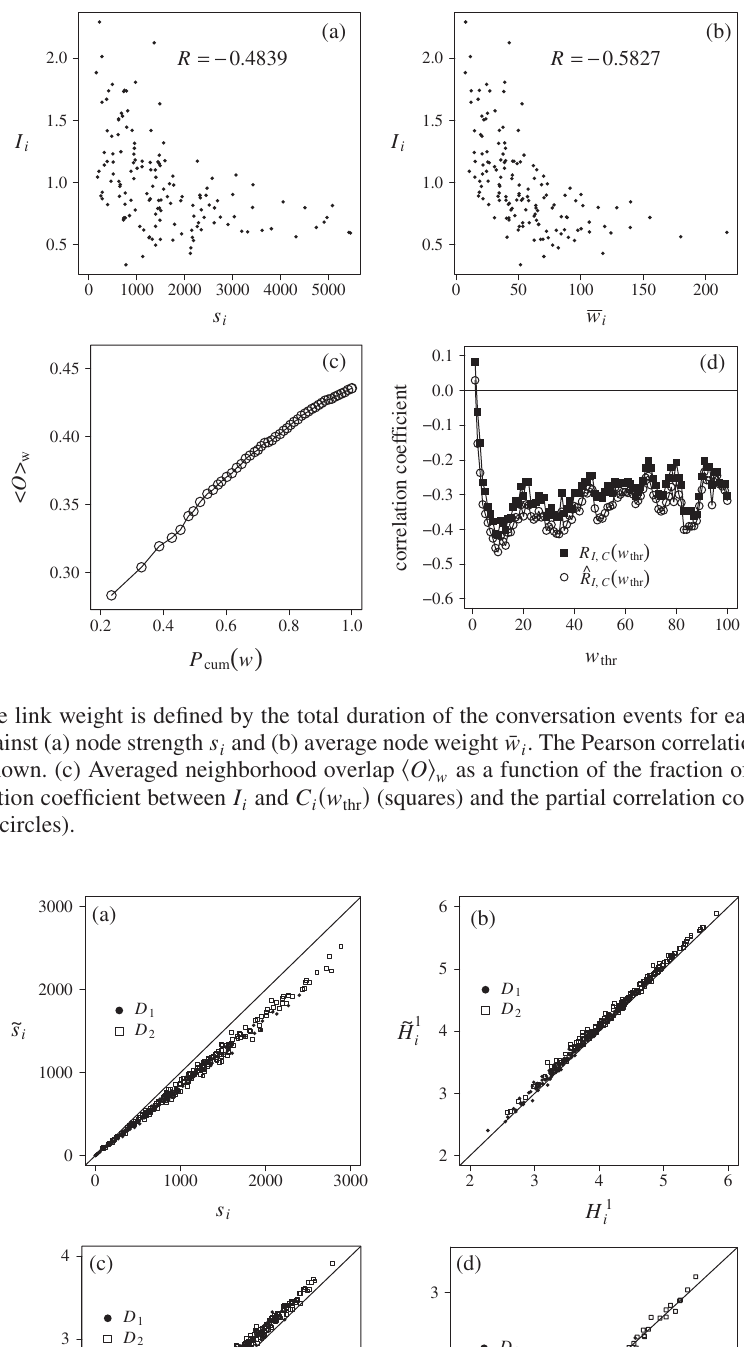
and D . (a) Node strength, (b) uncorrelated entropy, 1 2